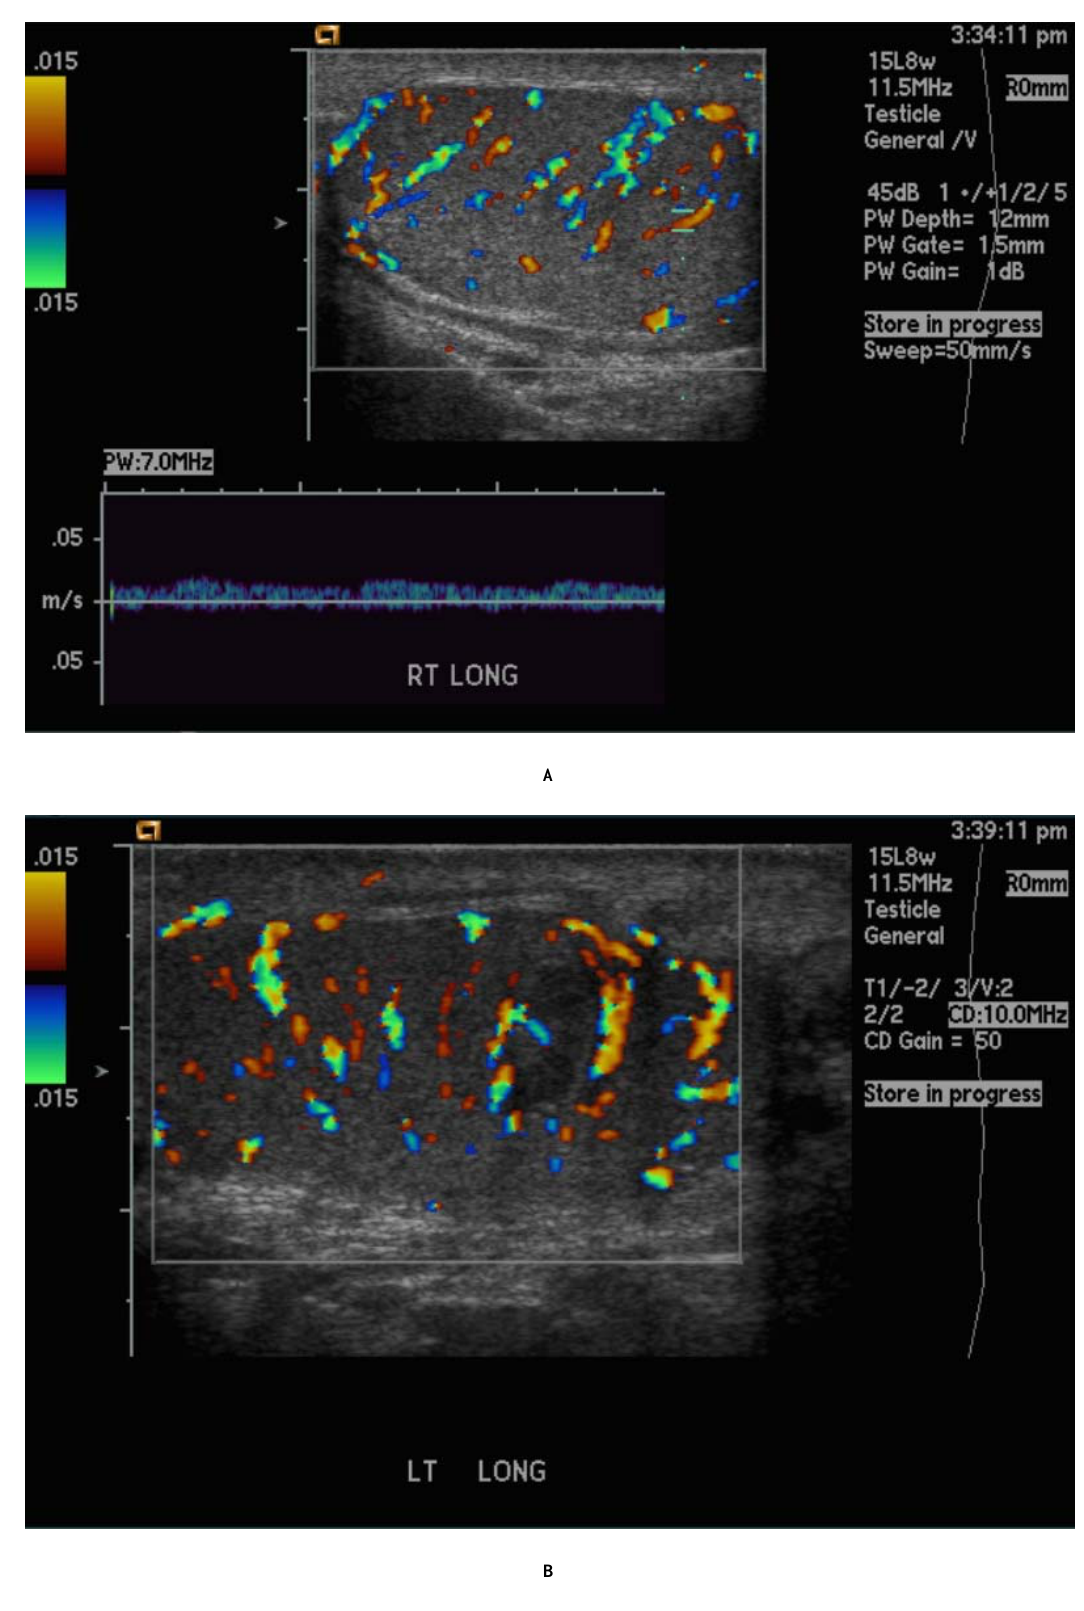
FIGURE 3 . Improvement in (A) right testicle and (B) left testicle appearance and blood